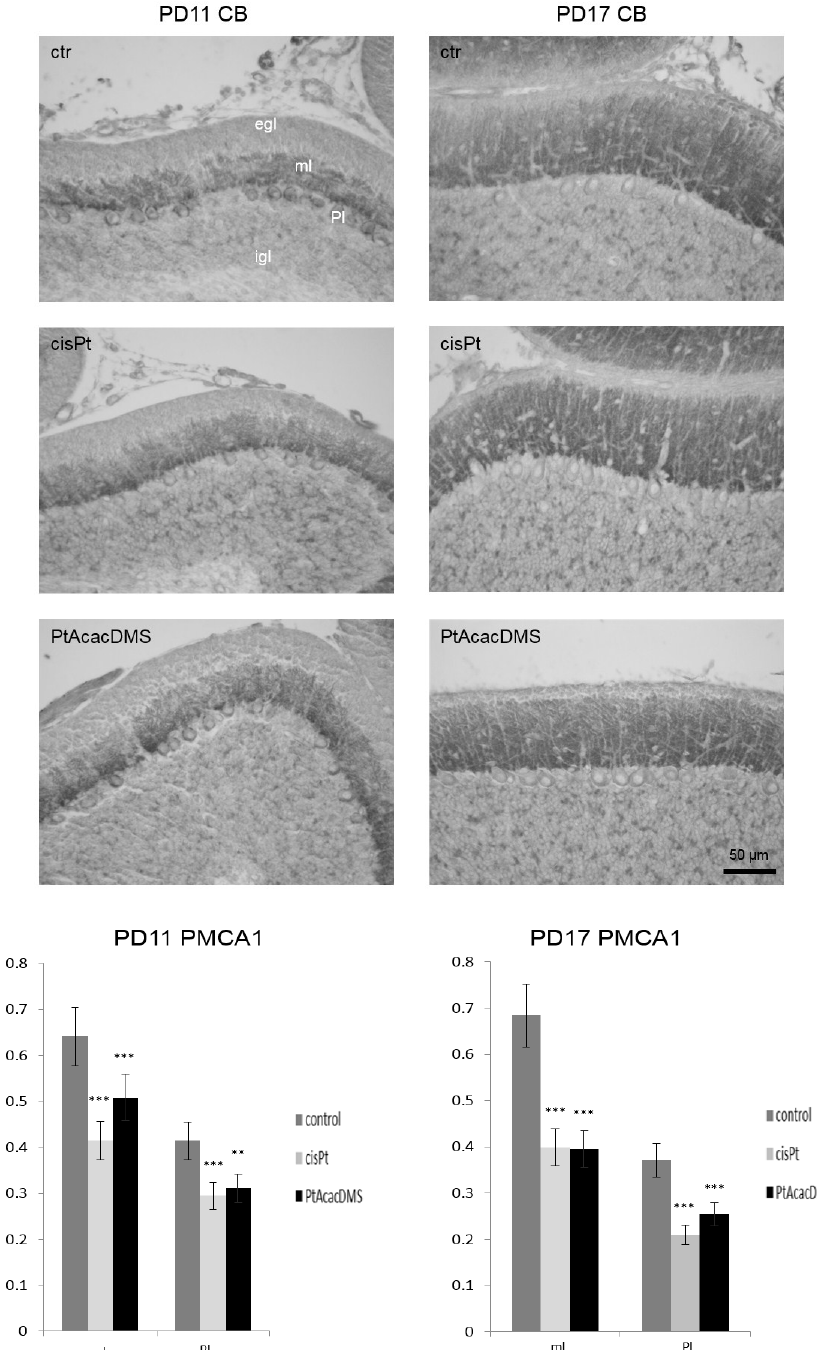
Figure 3. PMCA1 immunocytochemistry in the Purkinje neurons. At PD11 , control rats (ctr) show intense labelling on the cell membrane of Purkinje cells; the cytoplasm is weakly positive while strong immunoreactivity is present in the molecular layer, in the Purkinje cell dendrite branches. After, cisPt and PtAcacDMS decreased labelling on the cell membrane and in the cytoplasm are observed, as well as in the molecular layer. At PD17 , controls show a weak immunoreactivity vs. PD11; changes are observed after both platinum compounds treatment. Histograms show the OD values and the significance of differences is reported (** p < 0.01; *** p < 0.001). egl: External granular layer; ml: Molecular layer; igl: Internal granular layer; Pl: Purkinje cell layer. Scale bar: 50